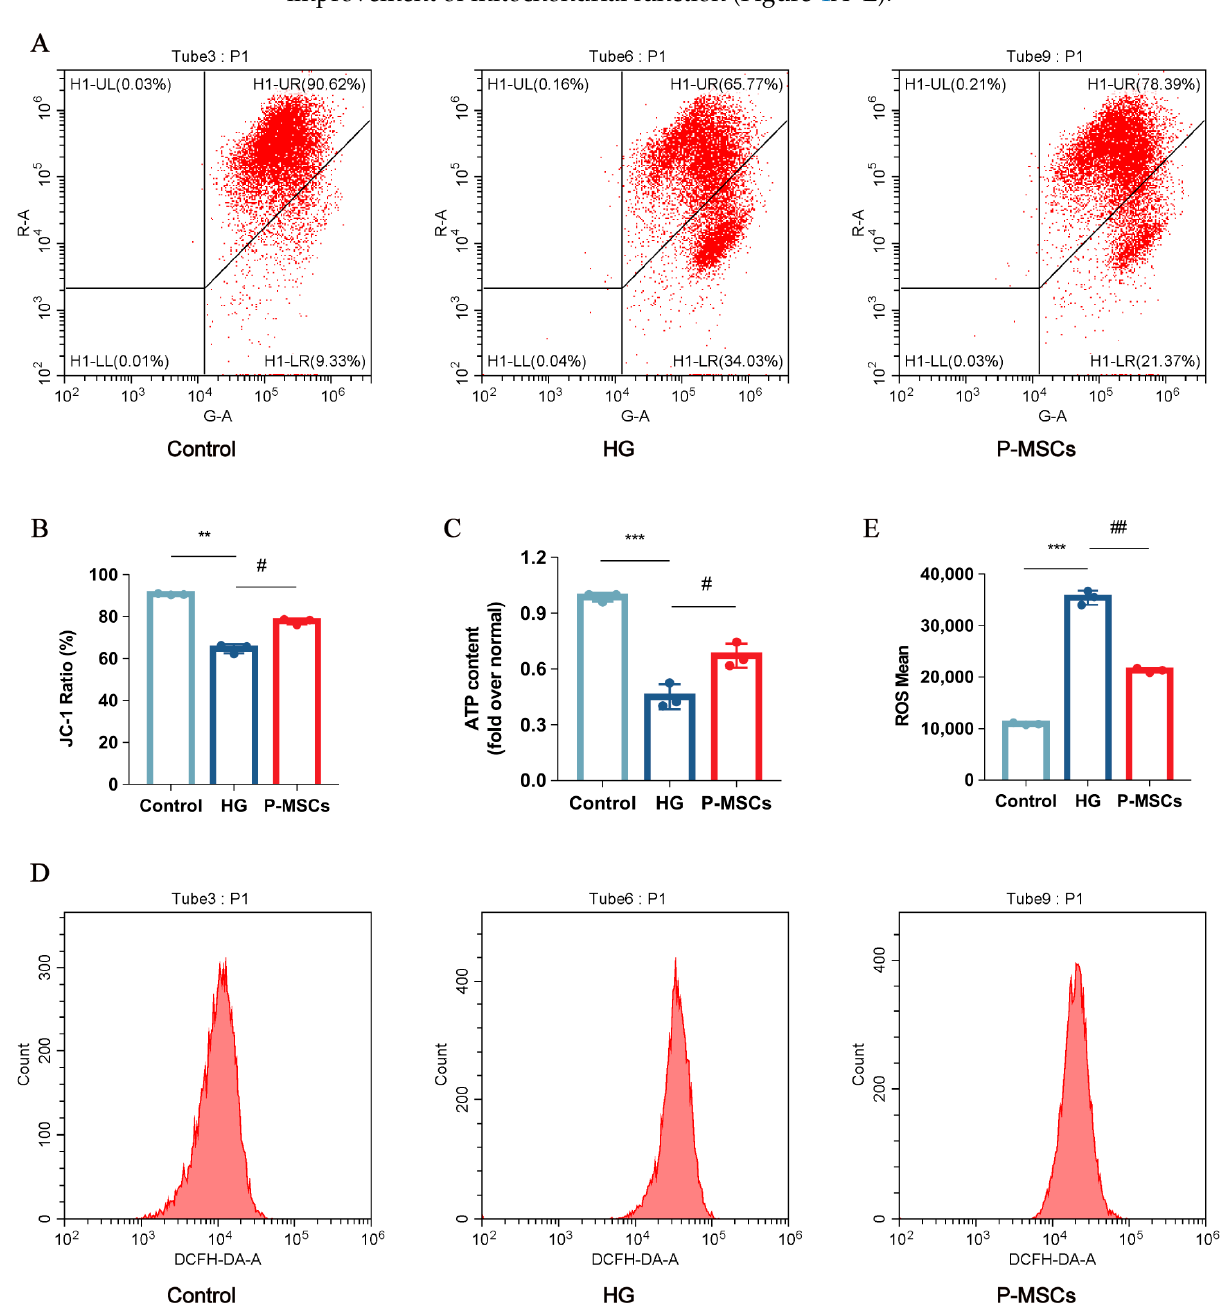
Figure 4. P-MSCs extenuated HG-mediated mitochondrial dysfunction and ROS Figure 4. P ‐ MSCs extenuated HG ‐ mediated mitochondrial dysfunction and ROS accumulation. ( A ) Mitochondrial membrane potential was measured by flow cytometry. ( B ) Mitochondrial membrane potential was quantified in MPC5. ( C ) ATP levels were quantified in MPC5. ( D ) ROS was measured by flow cytometry. ( E ) ROS were quantified in MPC5. n = 3 for ( A – E ). Data are shown as the means ± SD from three independent experiments. ** p < 0.01 and *** p < 0.001 vs. control, # p < 0.05 and ## p < 0.01 vs. HG.